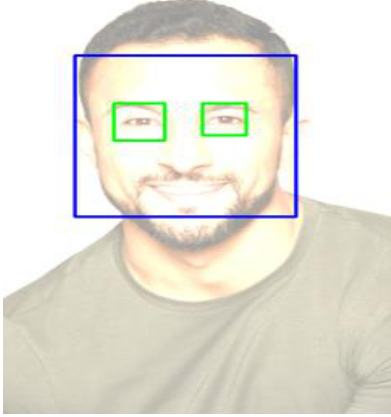
Figure 17. Again slightly increasing the brightness of Figure 15.